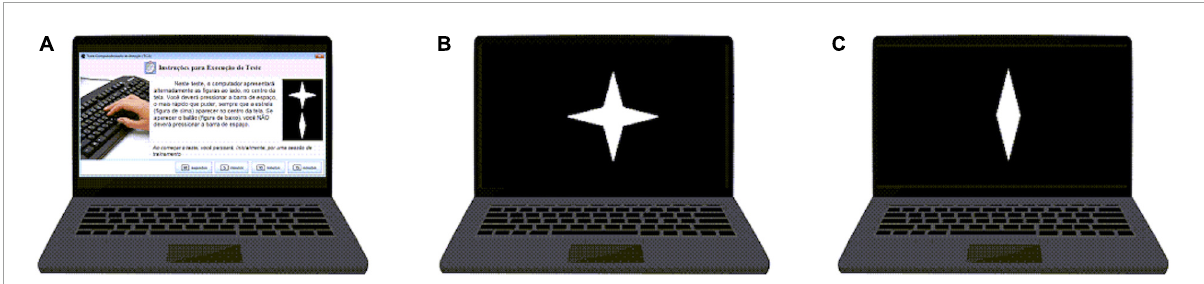
FIGURE1 Continuous Visual Attention Test (CVAT). This version of the CVAT begins with written instructions on the screen (A) The computer alternately displays the indicated figures at the center of the screen. The participant must press the spacebar using her/his dominant hand as fast as she/he can whenever the star appears at the center of the screen. The participants are instructed to not press the spacebar if the other figure appears. These instructions are read aloud by the interviewer. The target (B) remains on screen for 250 milliseconds (ms). The non-target (C) also remains on screen for 250 ms. There was one block with 90 trials (two Figures – both targets and non-targets – were presented, one each time). The interstimulus interval was 1 s. The entire test took 1.5 min to be completed. Variables: Omission errors (OE), Commission errors (CE), Average reaction time for correct responses (RT), and reaction time variability (VRT). The CVAT is open for registered psychologists upon request. English, Portuguese, and Spanish versions are